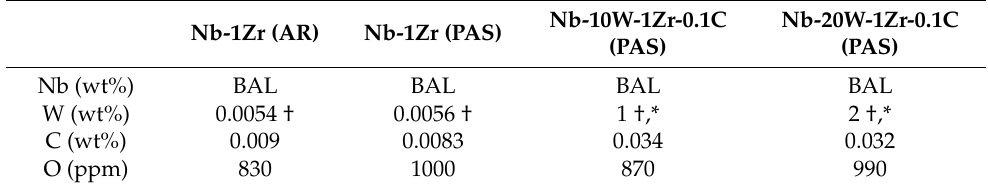
Table 2. Chemistry as measured by ICP-OES and LECO for Nb-1Zr as received powder, and for all 3 alloy powders after PAS and Nb-W-Zr-C powders.